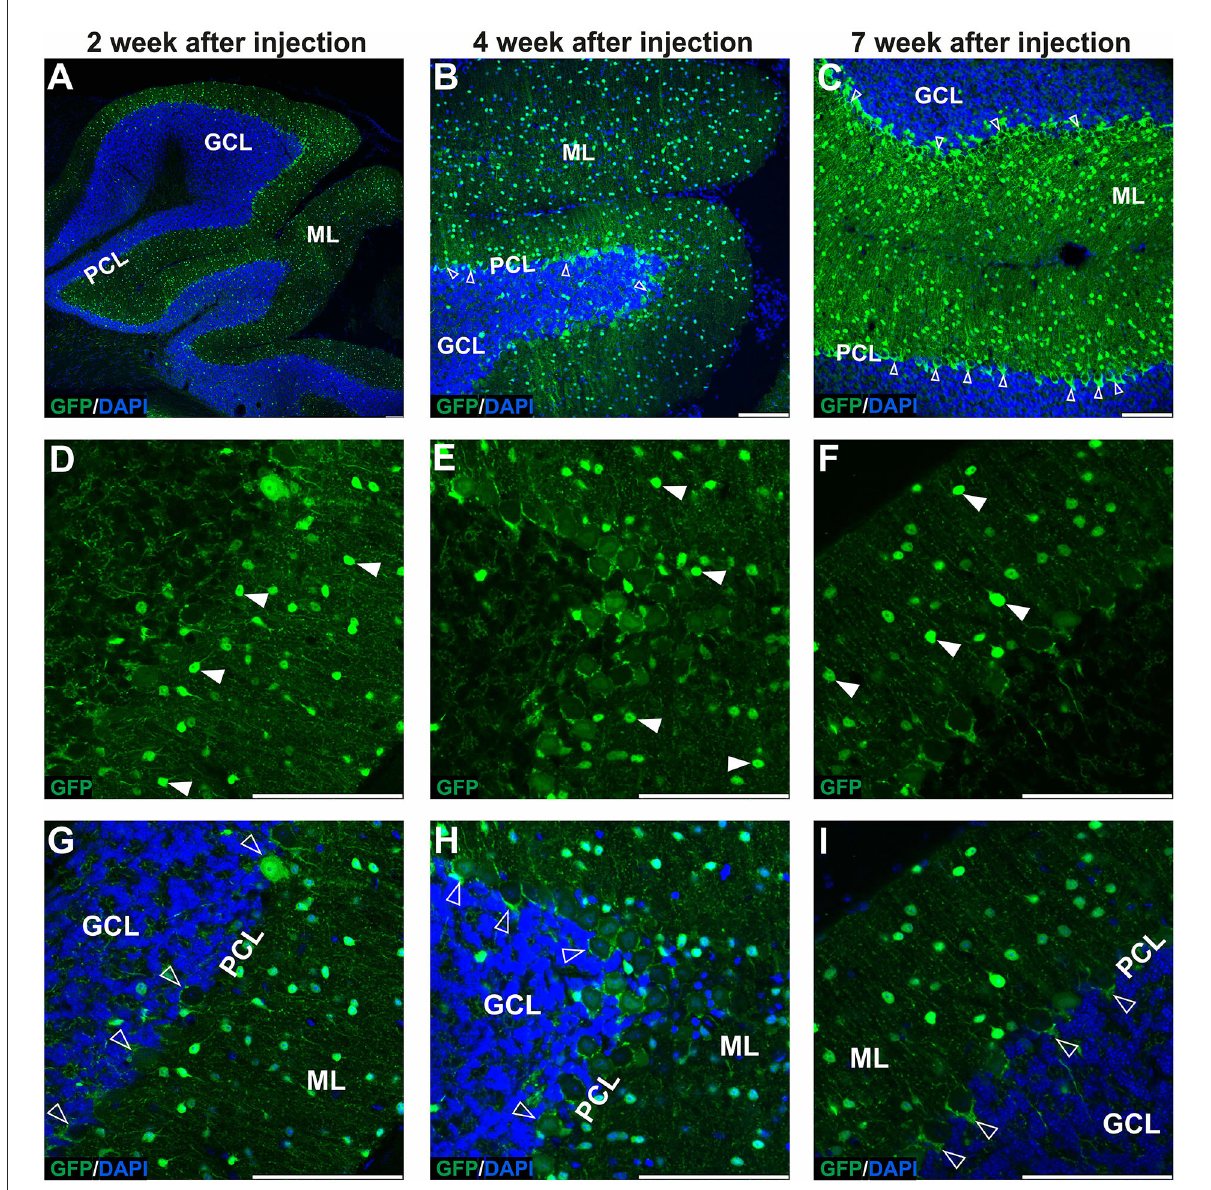
FIGURE1 The early transduction phase of the mouse cerebellum after injection of the eGFP-encoding AAVrh10 vector into cerebellar lobules. The transduction pattern was detected by imaging eGFP + cells at 2 (A,D,G) , 4 (B,E,H) , and 7 weeks post-injection (C,F,I) . The eGFP + cells were observed in the molecular layer (arrowhead, D–F ), which demonstrated small cell bodies and characteristic locations reminiscent of stellate cells. Importantly, no eGFP expression was observed in Purkinje cells. In addition, a strong eGFP + signal was observed in characteristic structures called pinceau and wrapped around eGFP-negative Purkinje cell bodies (unfilled arrowhead, B,C,G–I ). Such characteristic structures are long known exclusively as parts of the processes of basket cells. In summary, the transduction phase demonstrated transduction of the molecular cell layer and lack of transduction in Purkinje cell and granule cell layers. (A–C,G–I) eGFP green staining was merged with DAPI blue nuclear staining. Arrowheads: eGFP + cells in ML. Unfilled arrowheads: pericellular baskets and pinceau; GCL, granule cell layer; ML, molecular layer; PCL, Purkinje cell layer. Coronal sections. Bars: 100 µ m in the lower right corner of images. Purkinje cell and granule cell transduction: < 1%; N = 3 animals, see Figure